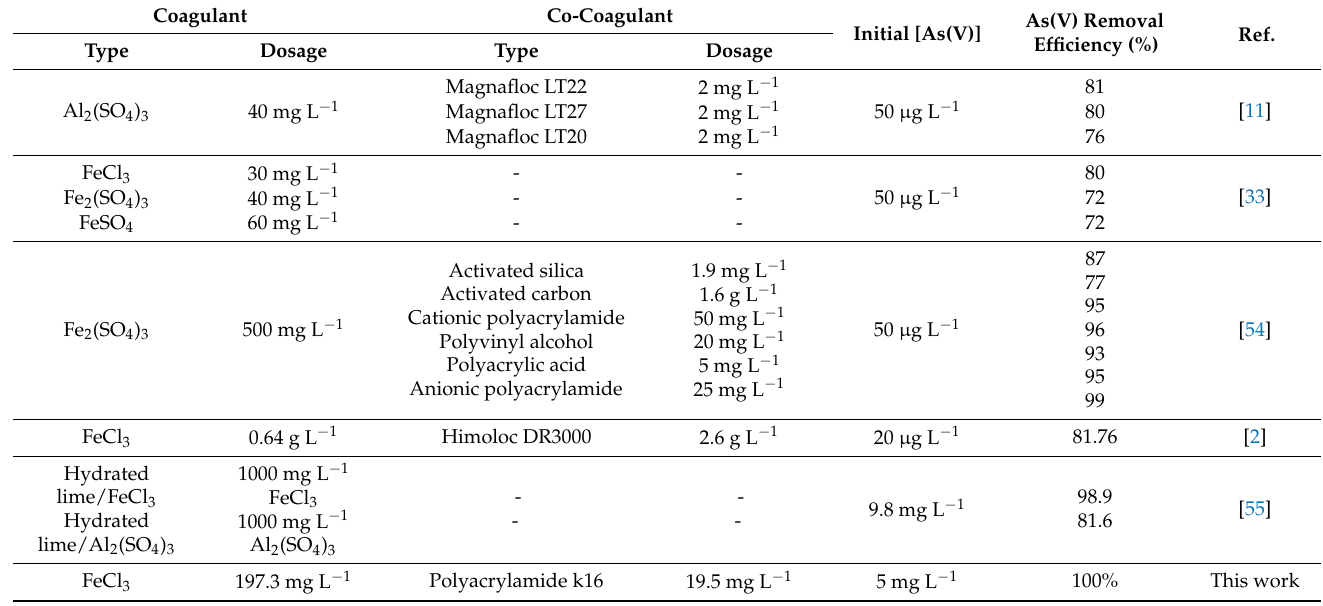
Table 2. A comparison of As(V) removal efficiency through coagulation-flocculation methods with different coagulants and